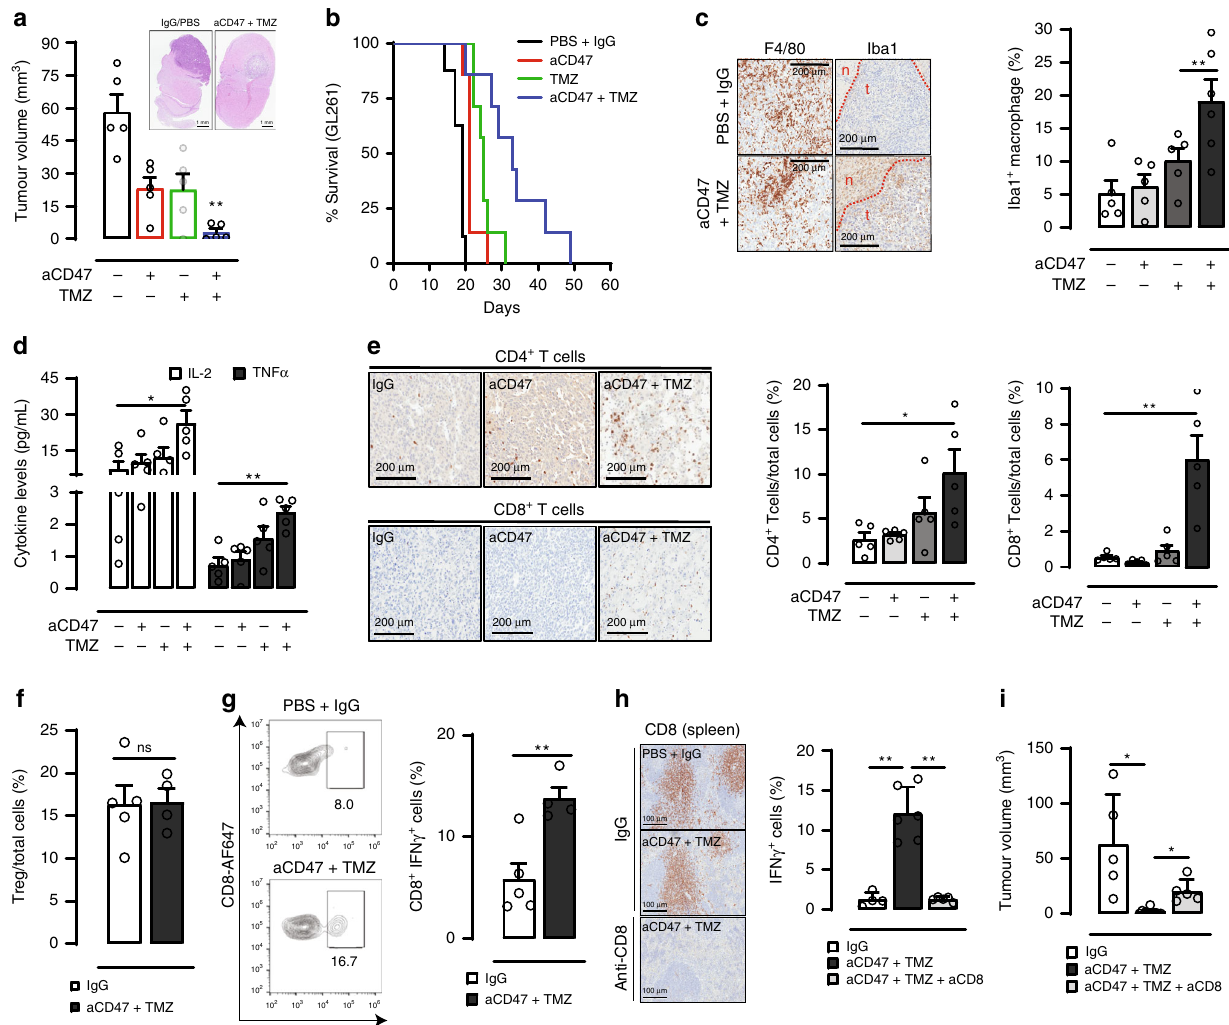
Fig. 5 Combination of TMZ and anti-CD47 induces anti-tumor immune response in murine GBM models. a Sequential TMZ and anti-CD47 antibody combined treatment inhibited growth of murine GBM (GL261). n = 5/group, ** p < 0.01, unpaired Student ’ s t test vs. aCD47 or TMZ. b Sequential TMZ and anti-CD47 antibody combined treatment prolonged animal survival. Control, n = 8; other groups, n = 7. ** p < 0.05, log-rank test. c Combination TMZ and anti-CD47 antibody treatment signi fi cantly increased the number of Iba1 + activated mononuclear cells within tumors, but not the total number of F4/80 + cells. Combo, n = 6; other groups, n = 5. ** p < 0.01, unpaired Student ’ s t test. d Combined TMZ and anti-CD47 antibody treatment elevated the levels of peripheral blood cytokines. n = 5, ** p < 0.05, one-side ANOVA with Bonferroni post hoc correction. e Intratumoral in fi ltrating CD4 + and CD8 + T cells were increased by combination TMZ and anti-CD47 antibody treatment. Scale bar = 200 μ m, n = 5, ** p < 0.01, one-side ANOVA with Bonferroni post hoc correction. f , g Combination TMZ and anti-CD47 antibody treatment did not result in signi fi cant changes to intratumoural regulatory T-cell content, but increased the number of IFN γ -producing CD8 + T cells within tumors. Control, n = 5; combo, n = 4. ** p < 0.01, unpaired Student ’ s t test. ns not signi fi cant. h In vivo depletion of CD8 + T cells using an anti-CD8 antibody completely eliminated the intratumoural IFN γ + CD8 + T cells. Scale bar = 200 μ m, Control, n = 4; combo, n = 6; combo + aCD8, n = 5. ** p < 0.01, unpaired Student t test. i CD8 + T cells depletion diminished the antitumor effect of combination TMZ and anti-CD47 antibody treatment. Control, n = 5; combo, n = 10; combo + aCD8, n = 5 * p < 0.05, unpaired Student t test. All error bars = mean ± standard